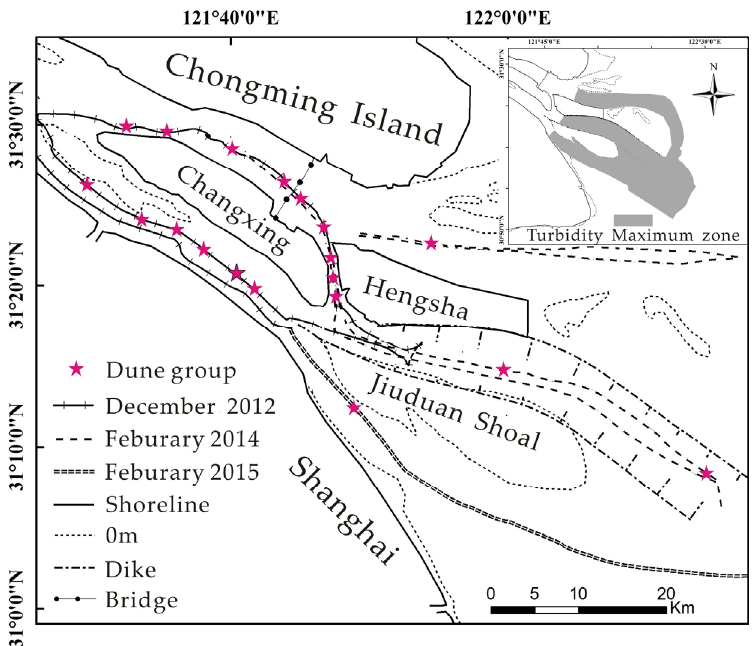
Figure 2. Field measurement routes and locations of the turbidity maximum zone in the Yangtze River estuary, China.